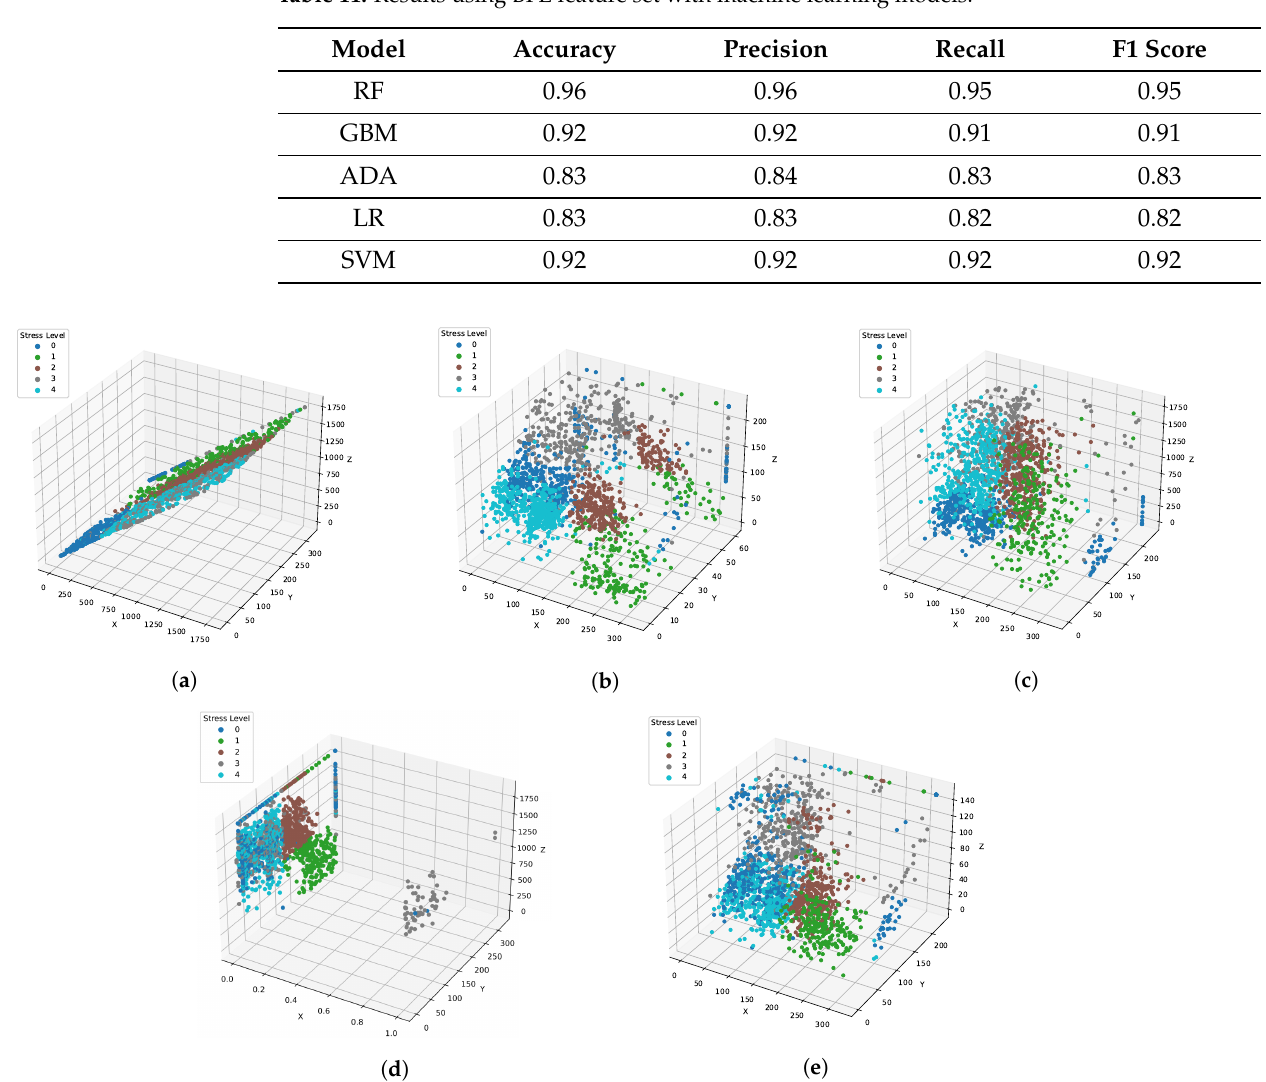
Table 11. Results using BFE feature set with machine learning models.